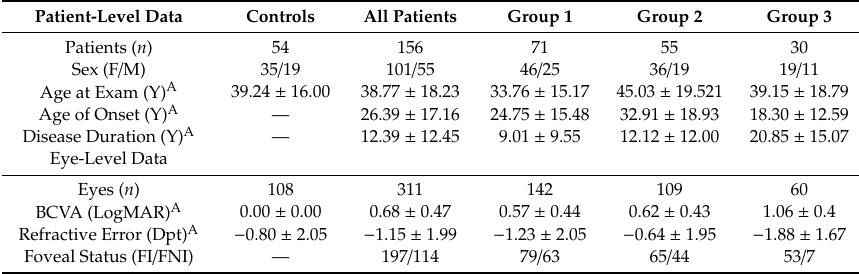
Table 1. Demographic and functional data of all included